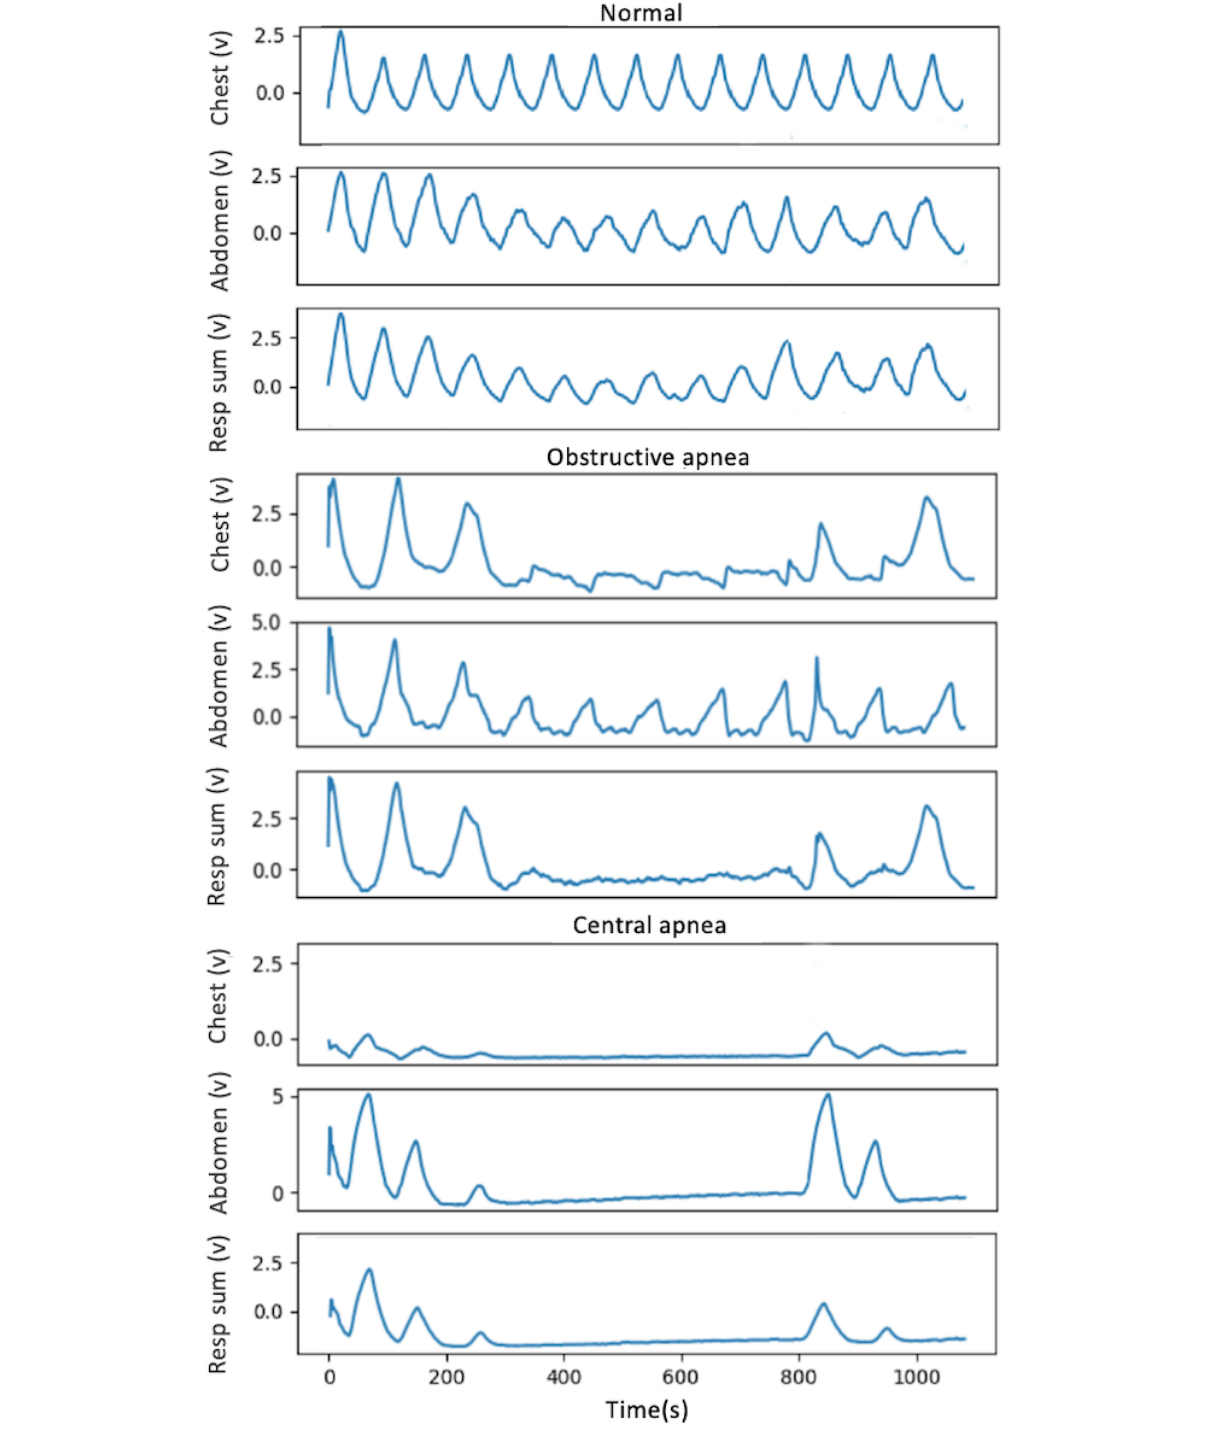
Figure 1. Difference between the movements of the chest and abdomen and the sum of the two movements during obstructive apnea (OA), central apnea (CA), and normal breathing. During normal breathing, chest and abdomen movements are in phase. During OA, breathing effort and airway blockage result in the out-of-phase movement of the chest and abdomen, and the sum of the two movement signals (respiratory sum) is close to zero. During CA, there is no movement in the chest or the abdomen. CA: central apnea; OA: obstructive apnea; Resp sum: respiratory